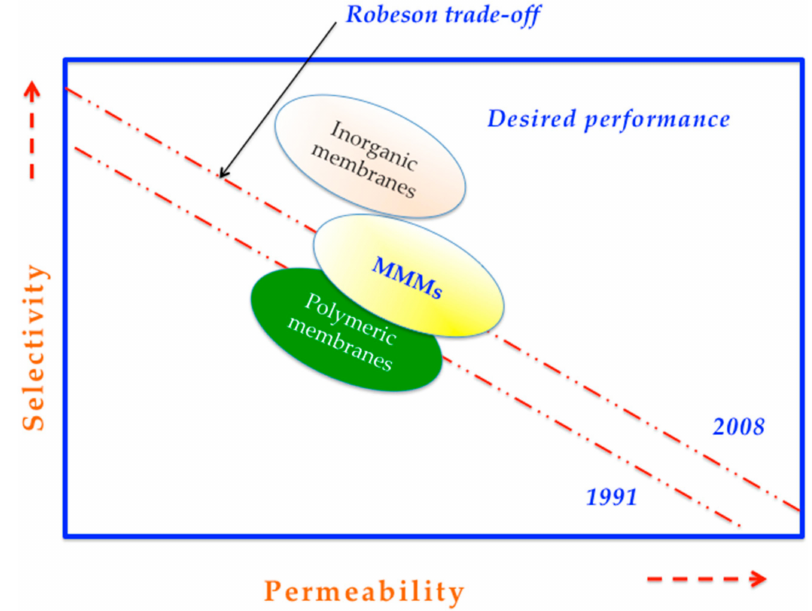
Figure 2. General drawing of Robeson relationship of polymeric membranes, inorganic and mixed matrix membranes (MMMs), and the desired performance